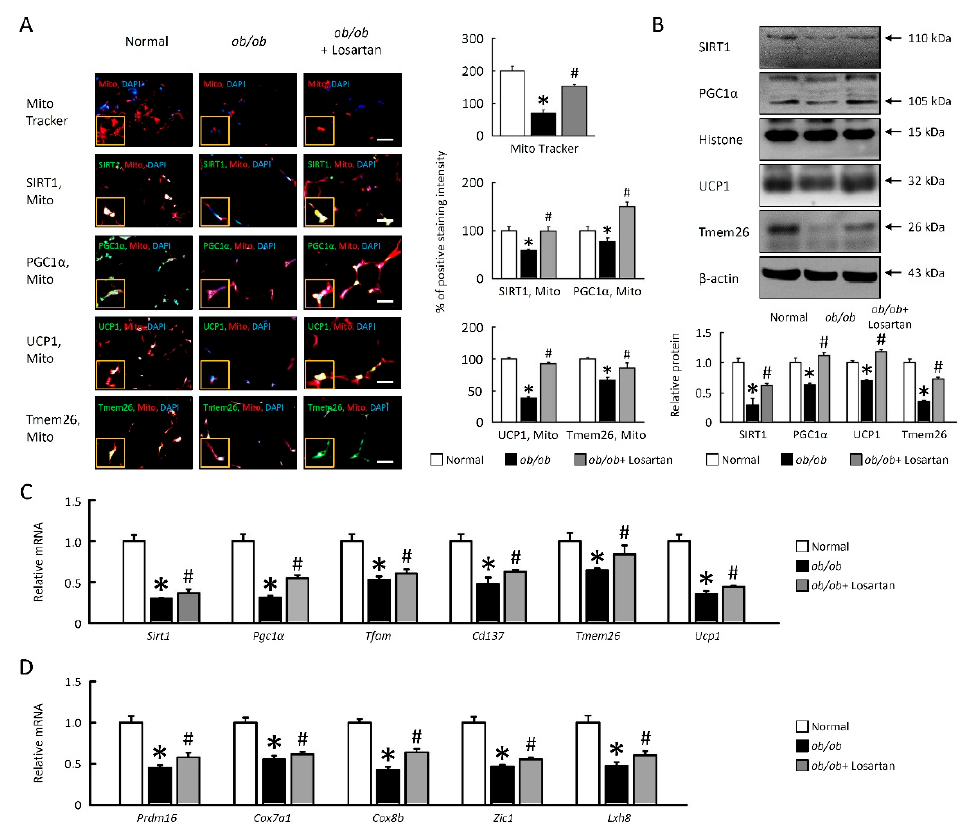
Figure 6. Losartan enhanced mitochondrial function and EWAT browning in ob/ob mice. ( A ) The staining for SIRT1, PGC1 α , UCP1, and Tmem26 are green, while the staining for mitochondria (Mito Tracker) is red. Scale bar: 100 µ m. Tissue staining, as quantified by either stain intensity, is represented on the left-hand vertical axis in each graph. ( B ) Quantification of SIRT1, PGC1 α , UCP1, and Tmem26 protein levels by Western blot of EWAT. Below graphs indicate quantification relative to Histone (for SIRT1 and PGC1 α ) and β -actin (for UCP1 and Tmem26). ( C ) Quantification of Sirt1 , Pgc1 α , Tfam , Cd137 , Tmem26 , Ucp1 , ( D ) Prdm16 , Cox7a1 , Cox8b , Zic1 , and Lxh8 by qRT-PCR. qRT-PCR indicates quantification relative to Gapdh . For each animal group, n = 5. All values represent the mean ± SEM. Data were analyzed by Student’s t test. * p ≤ 0.05, normal vs. ob/ob ; # p ≤ 0.05, ob/ob vs. ob/ob + Losartan. EWAT: epididymal white adipose tissue; SIRT1: sirtuin 1; PGC1 α : peroxisome proliferator-activated receptor gamma coactivator 1-alpha; UCP1: uncoupling protein 1; Tfam : mitochondrial transcription factor A; Prdm : PR domain zinc finger protein 16; Cox7a1 : cytochrome c oxidase; Zic1 : Zinc finger of the cerebellum 1; qRT-PCR: Quantitative real time polymerase chain reaction.